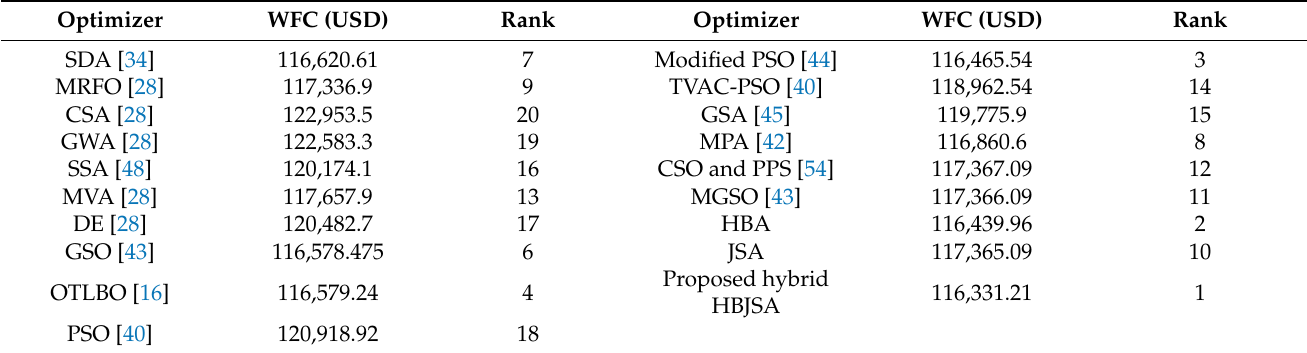
Table 4. Comparison between HBA, JSA, and HBJSA with respect to reported techniques for the 48-unit system of CHP economic